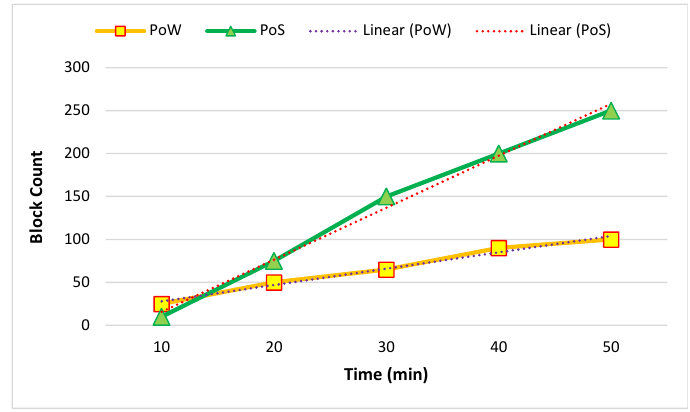
Figure 8. Average of five created nodes in one hour.